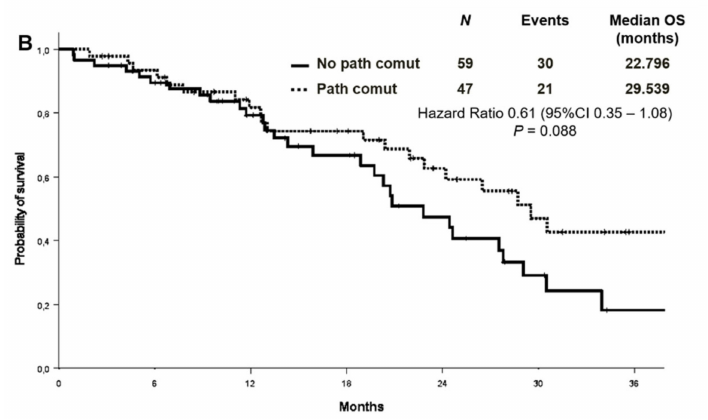
Figure 4. Progression-free survival ( A ) and overall survival ( B ) according to co-mutational